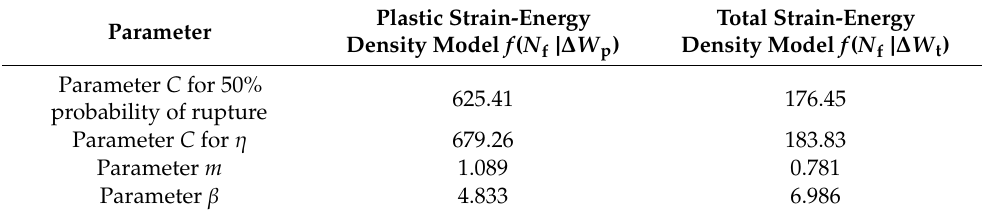
Table 2. Estimated parameters of the strain-energy fatigue-life durability